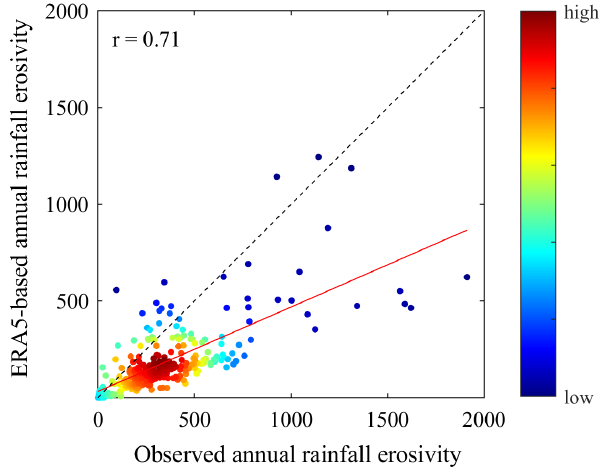
Figure 5. Comparison of mean annual rainfall erosivity based on observed and ERA5-based results for 7 years (2013–2020, exclud- ing 2017). The dashed line is the result of an optimal model (with an intercept of 0 and regression coefficient of 1). The red line is the regression result. Colors of dots represent the grid density. Unit:MJmmha − 1 h − 1 yr − 1 .